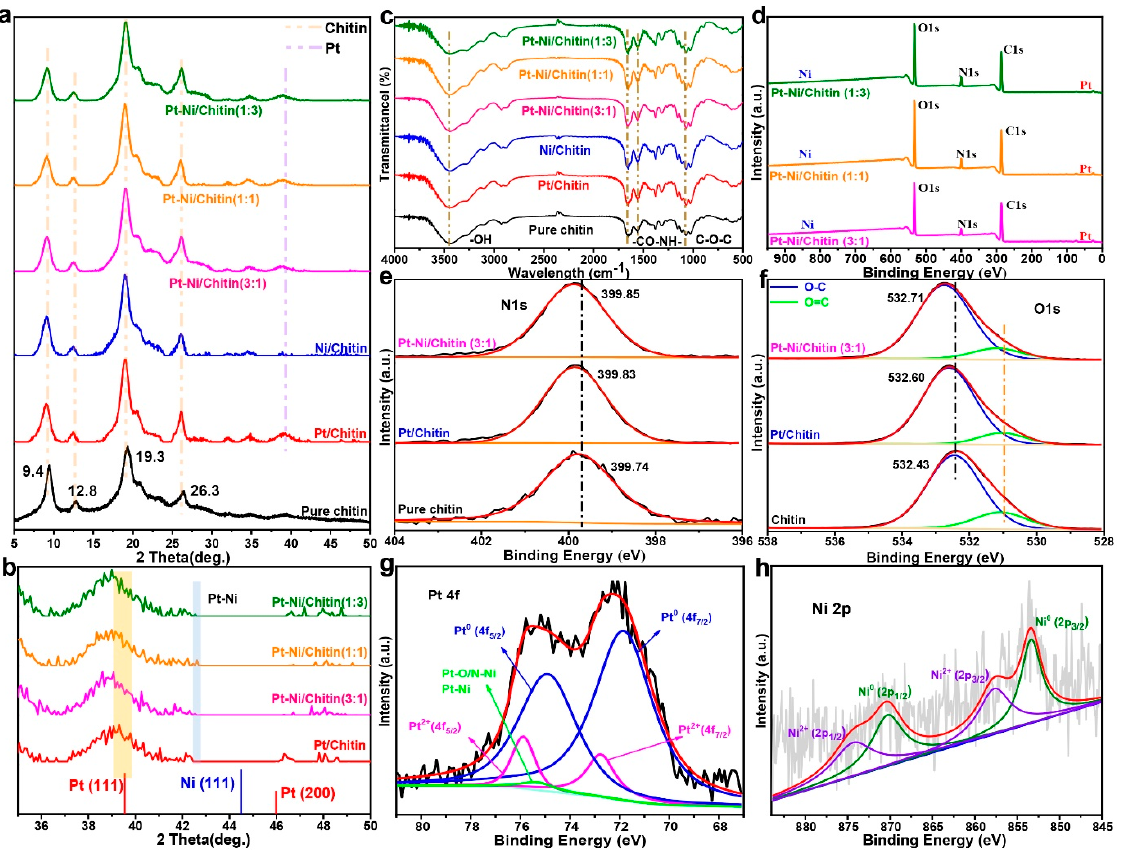
Figure 2. XRD patterns of the chitin supported catalysts ( a ). A partial enlargement of XRD patterns ( b ). FT-IR spectra of the chitin supported catalysts ( c ). The full scale XPS spectra of the Pt-Ni bimetallic catalysts ( d ). XPS spectra of N 1s ( e ), O 1s ( f ) of the pure chitin, Pt/Chitin, and Pt-Ni/Chitin. Pt 4f spectrum of the Pt-Ni/Chitin ( g ). Ni 2p spectrum of the Pt-Ni/Chitin ( h